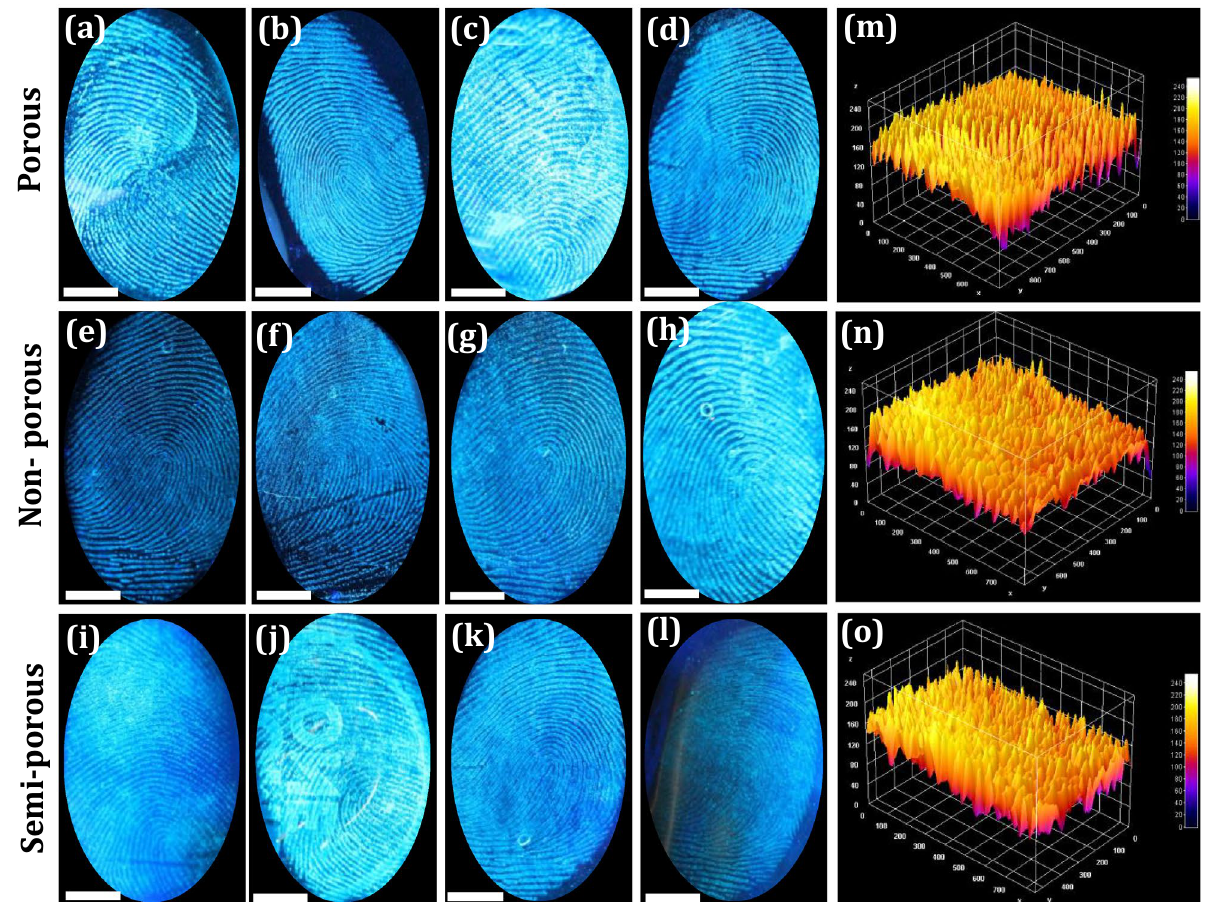
Figure 6. FPs images on different surfaces ( a–d ) non-porous, ( e–h ) porous, and ( i–l ) semi-porous substrates developed by spraying with FDIP solution followed by PVA masking and visualized under UV 365 nm irradiation. The corresponding grayscale images are shown in Fig. S7; ( m–o ) 3-dimensional interactive plots of the corresponding FP ( d,e,k ), which reveals the uniform distribution of the prepared solution over the ridges (Scale bar: 5